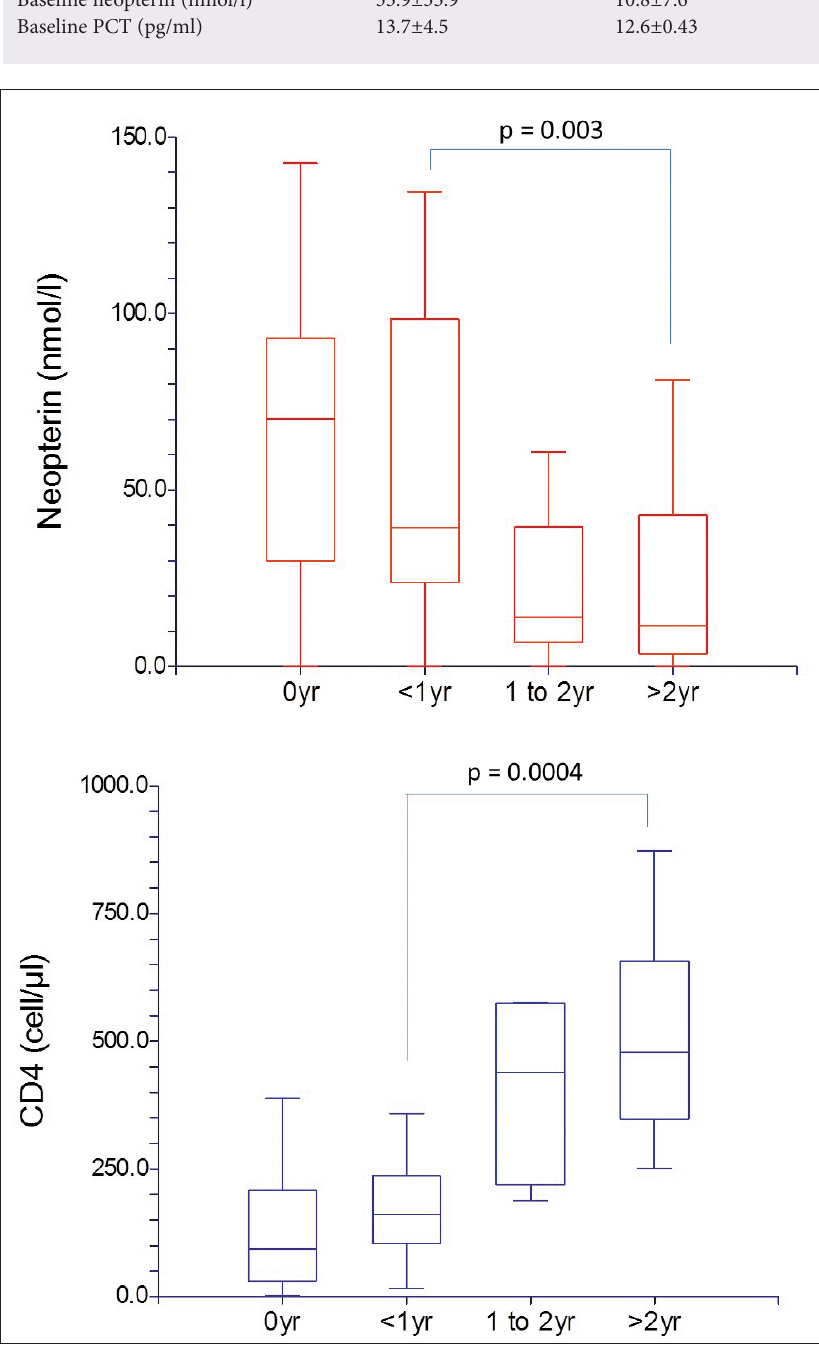
Fig. 1. Box plots illustrating neopterin and CD4 levels for patients after 0 years ( n =25), <1 year ( n =30), 1 - 2 years ( n =10) and >2 years ( n =10) on ART.